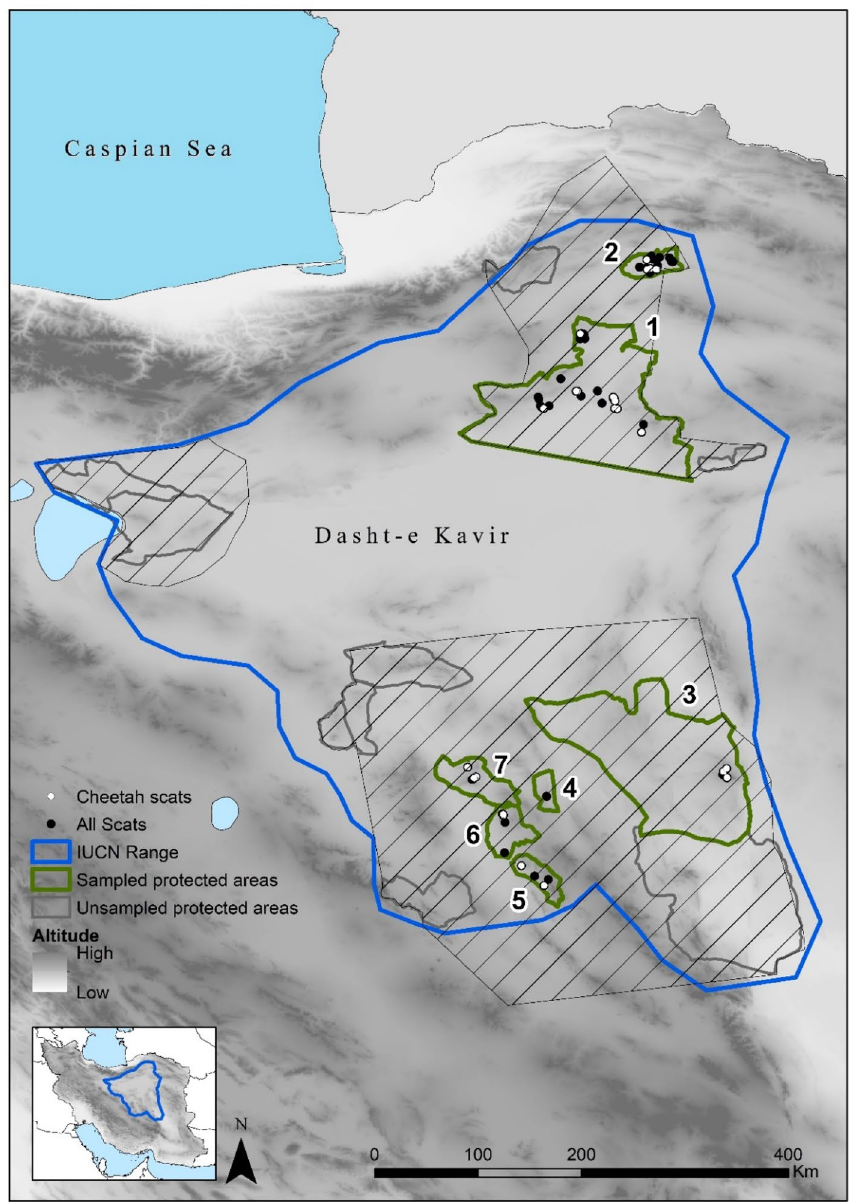
Figure 1. Current distribution of Cheetah in Iran (small inset) and location of subpopulations/protected areas from which samples were available for this study. The dashed lines depict the estimated boundaries of each subpopulation: Northern in the north, Southern in the south and Kavir in the west. Northern Subpopulation: (1) Touran Biosphere Reserve, (2) Miandasht WR and Zamen-e Ahoo NP; Southern subpopulation: (3) Naybandan WR; (4) Kamki Bahabad HPA, (5) Bafgh PA, (6) Ariz HPA, (7) Dareh Anjir WR. This figure was produced using ArcGIS (version 10.3.1 [www. esri. com/ softw are/